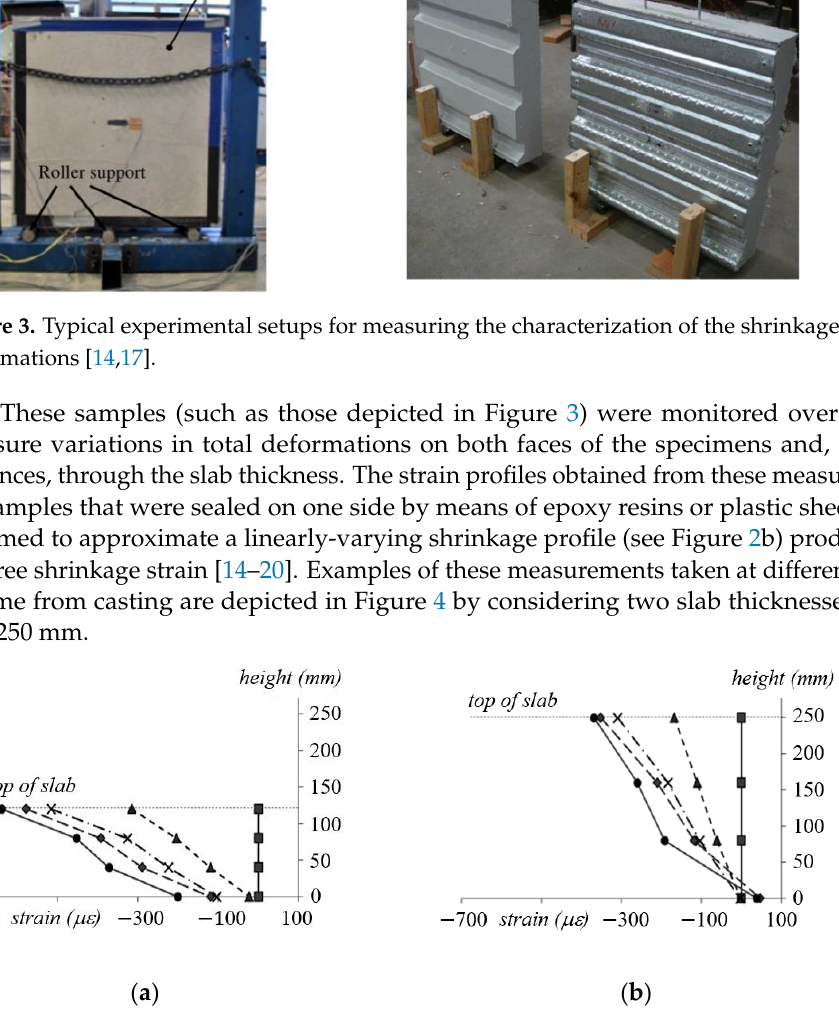
Figure 4. Total deformations measured at 15, 36, 60, 126, and 192 days from casting for samples with different thicknesses and with the top surfaces exposed to dry and bottom surfaces sealed with plastic: ( a ) slab thickness of 120 and ( b ) slab thickness of 250 mm [15].